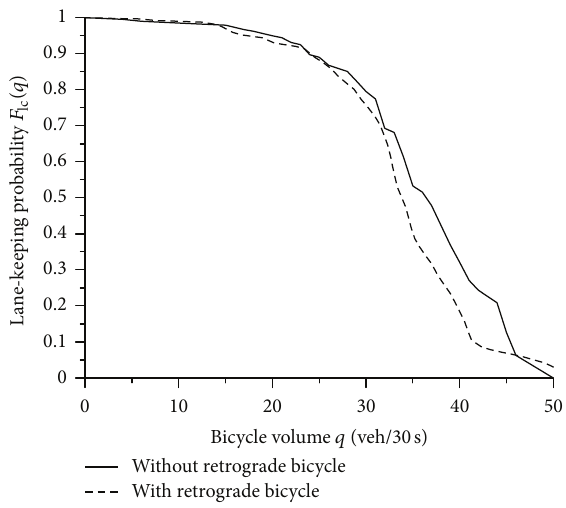
Figure 4: Effect of retrograde motion on lane-keeping